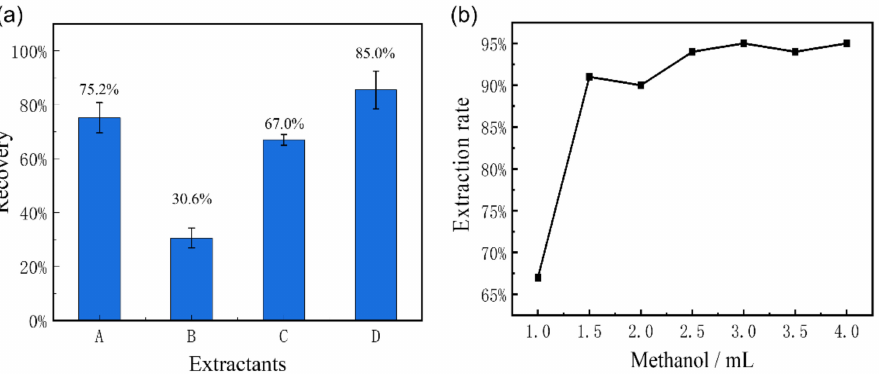
Figure 1. ( a ) The recovery of FZD with different extractants, including acetonitrile (A), dichloromethane (B), ethyl acetate (C), and acetonitrile/methanol (1/1) mixture (D); ( b ) the elu- tion curve with the